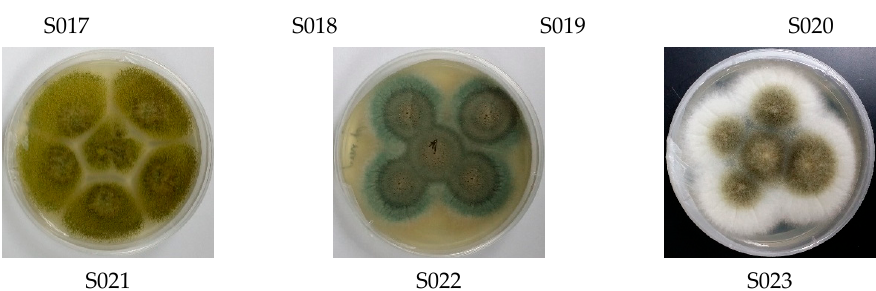
Figure 1. Morphological photos of the 23 derived fungal isolates (S001–S023).